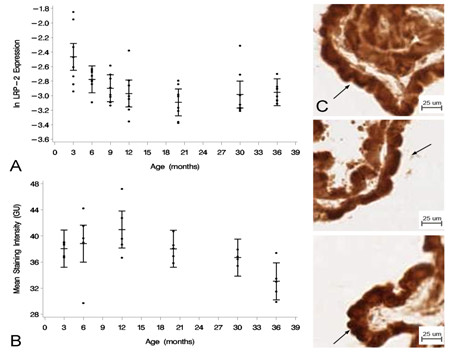
Expression of LRP-2 at the CP with age. (A) Graph of the log-transformed normalized expression of LRP-2 with respect to age, n = 8 per age group. One-way ANOVA revealed a significant decrease (p = 0.0005) with age on LRP-2 expression. Significance was reached between 3 and 9, 12, 20, 30, and 36 mo. Error bars represent 95% confidence intervals for the means. (B) Semi-quantitative IHC for LRP-2 expression in grayscale units (GU). Mean staining intensity was significantly decreased (p <0.05) for the age groups, n = 5 per age group. (C) IHC of LRP-2 expression at 3 mo (top), 20 mo (center), and 36 mo (bottom) old rats. Staining is localized to the apical membrane (arrows), and is also seen subapically.